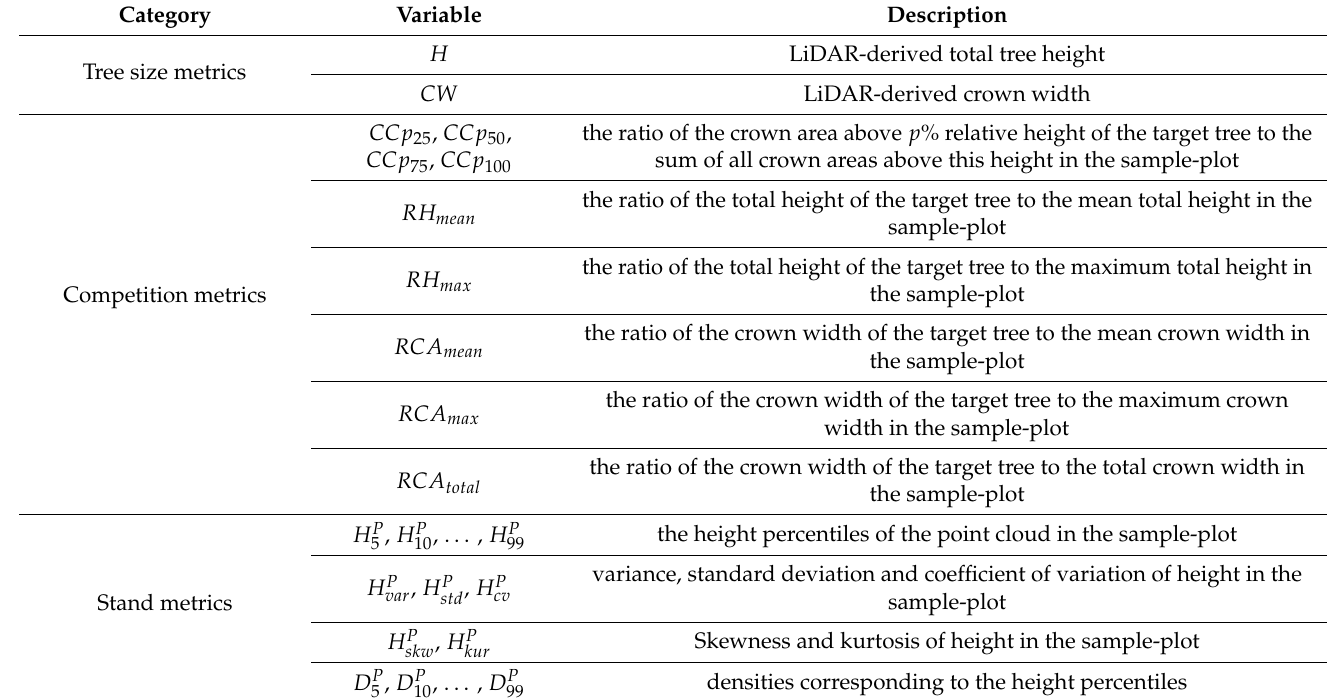
Table 2. Candidate trees and stand variables extracted by